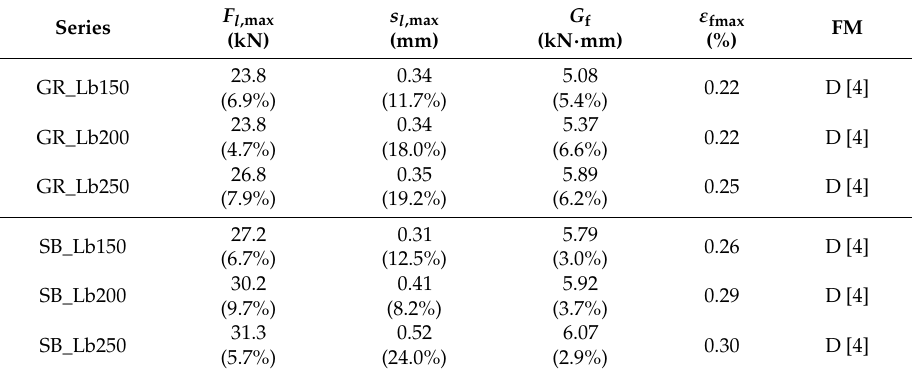
Table 4. Main results obtained from the single-lap shear tests (average